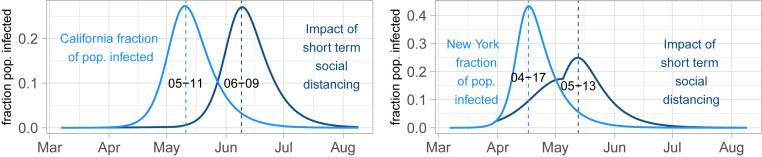
Scenarios for the impact of short-term social distancing: fraction of population vs. date. (Left) California SIR model based on mortality data with parameters from Table 1 (R0=2.7, γ=.12, I0=.1) under two scenarios: R0 constant in time (light blue) and R0 cut in half from 27 March (1 wk from the start of the California shutdown) to 5 May but then returned to its original value, to represent a short-term distancing strategy (dark blue). (Right) New York SIR model with parameters from Table 1 (R0=4.1, γ=.1, I0=05) under the same two scenarios but with short-term distancing occurring over the dates of 30 March (1 wk from the start of the New York shutdown) to 5 May. In both states, the distancing measures suppress the curve and push the peak infected date into the future, but the total number of cases is only slightly reduced.